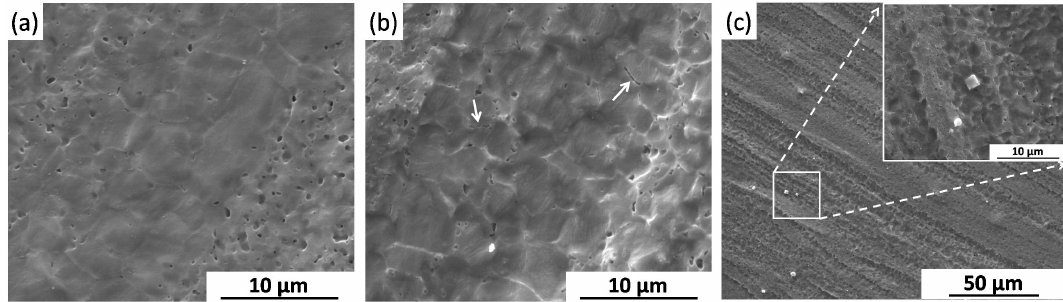
Figure 14. Surface morphologies of FSP specimens after different immersion time intervals in SBF: ( a ) 1 h; ( b ) 3 h; and ( c ) 12 h (without corrosion products).